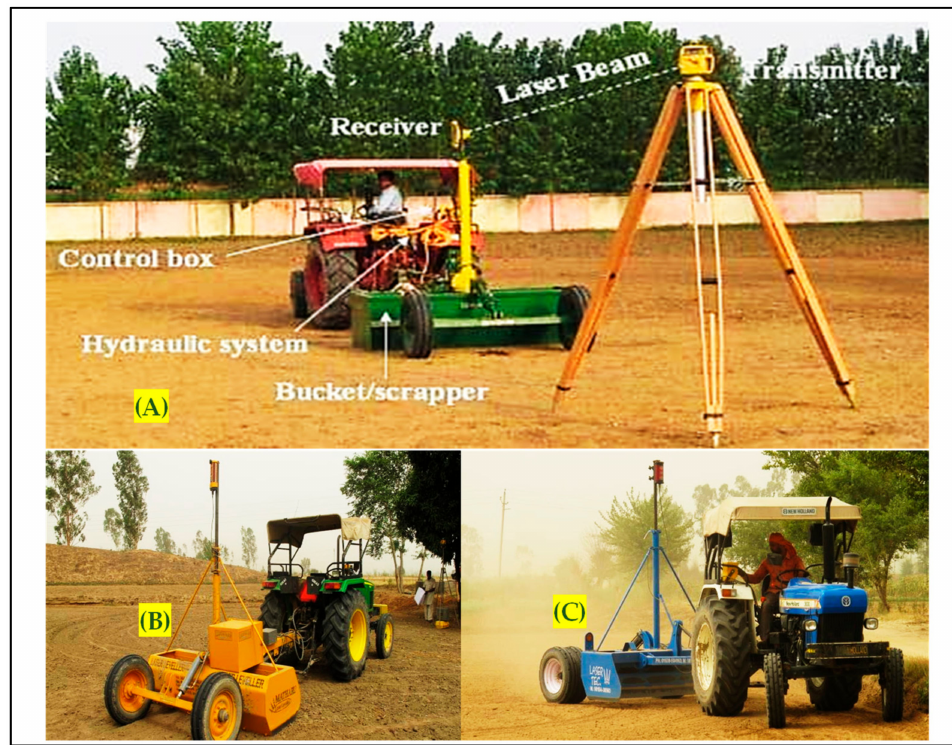
Figure 1. Precision laser land leveling (PLL) in field conditions, ( A ) showing the function of different components; ( B , C ) PLL in operation levelling a